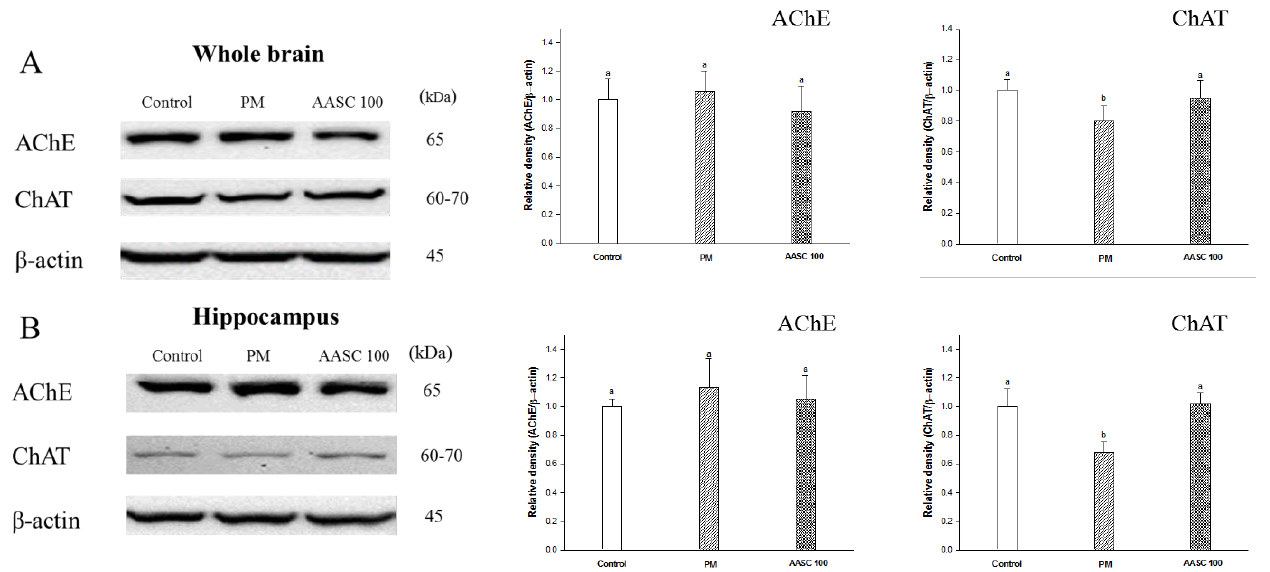
Figure 3. Effect of AASC on the cholinergic system in the brains of mice exposed to PM 2.5 . ( A ) Whole brain and ( B ) hippocampus. Results are indicated as mean ± SD ( n = 9). Different small letters represent the statistical difference ( p < 0.05) of each group in a high